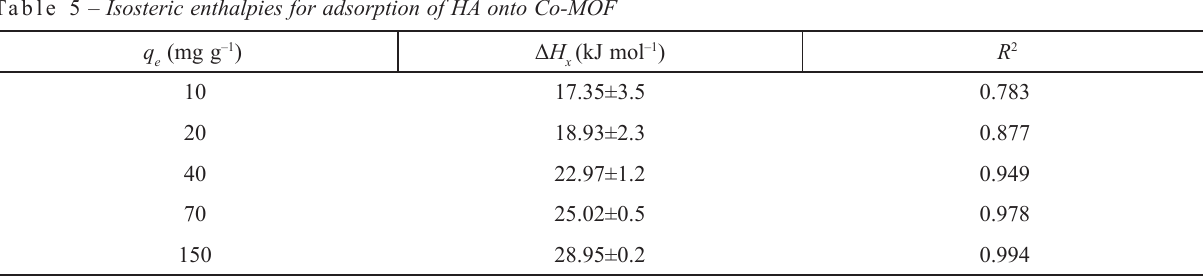
Table 5 – Isosteric enthalpies for adsorption of HA onto Co-MOF q (mg g –1 ) e